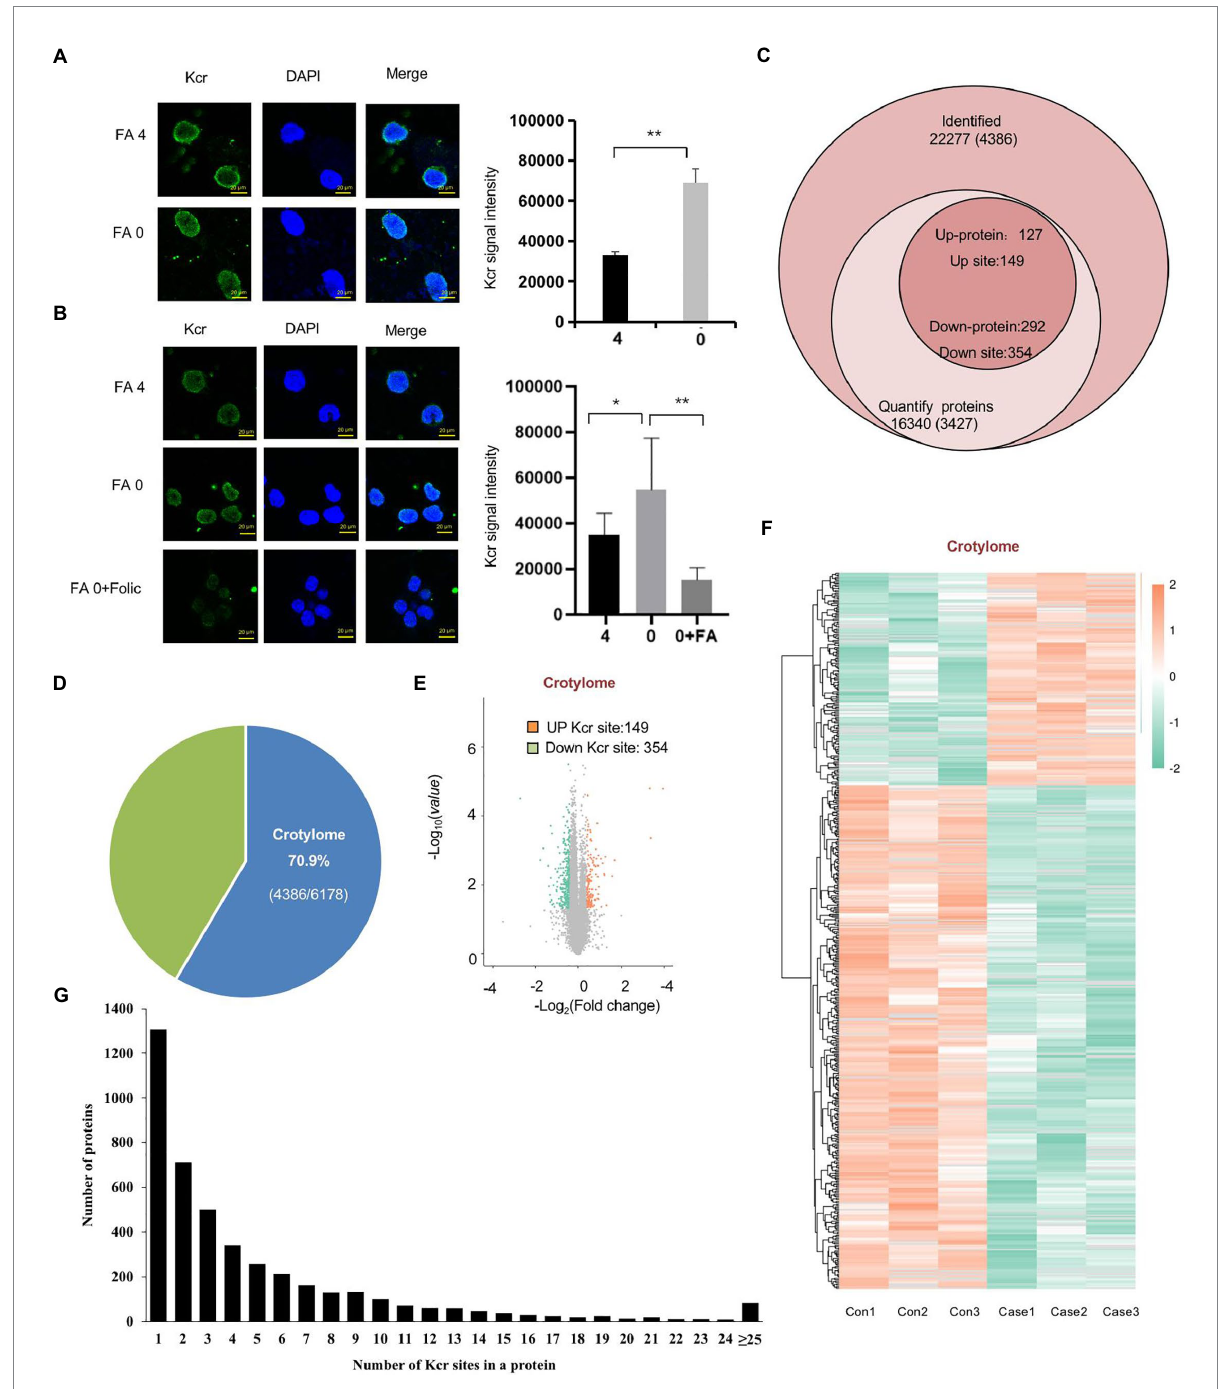
FIGURE 4 Global crotonylome analysis of folate-free mESCs. (A) Immunostaining using anti-crotonlytion (green) antibodies revealed discrete foci in mESCs under folate deficiency (B) and supplementary folinic acid (50 mg/l) for 24 h. Scale bar: 20 μ m. Data are shown as the mean (SD; n = 5). Nuclei were stained with DAPI (blue). * p < 0.05, ** p < 0.01, *** p < 0.001. (C) Global view of identified proteins and crotyl sites. Venn diagram showed the number of proteins and the corresponding identified crotyl sites in brackets. Crotylated proteins with a fold change greater than 1.5 or less than 0.667 and with p < 0.05 were considered as significantly up-regulated or down-regulated. (D) The relative ratio of crotylated proteins identified in crotylome to that in proteome. (E) A volcano plot demonstrating the dual thresholds for total numbers of Kcr sites in normal folate versus folate-free conditions. Each dot represents a single quantified Kcr site. The dots with color in the upper and outer quadrants represent Kcr sites, with green indicating a relative decrease and red indicating a relative increase in abundance (FC ≥ 1.40 or ≤ 0.71, p < 0.05). (F) Hierarchical clustering heatmap depicting individual samples and Kcr site differences between normal folate versus folate-free mESCs ( n = 3 per group). (G) Statistical map of differential modification